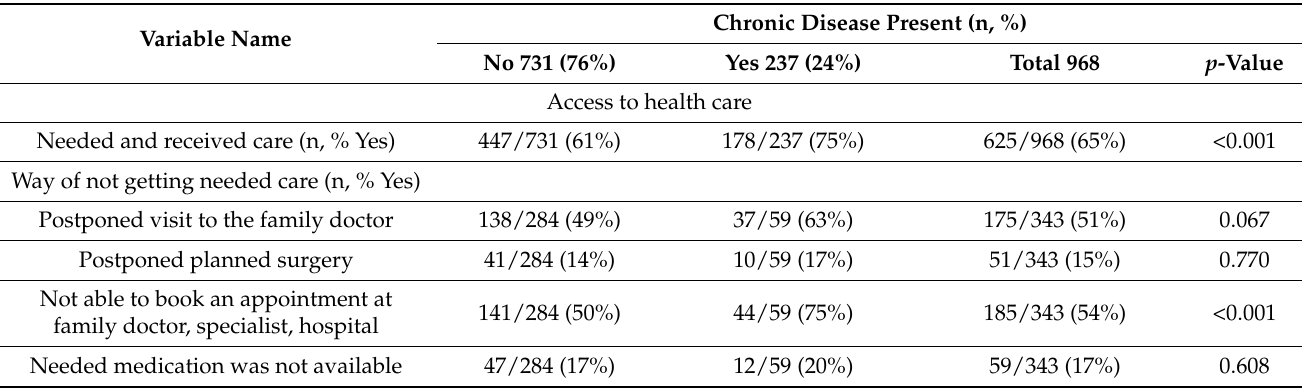
Table 3. Self-perceived access to care, postponements of care, and mental health in the adult population of Bosnia and Herzegovina during the COVID-19 pandemic by presence of chronic diseases